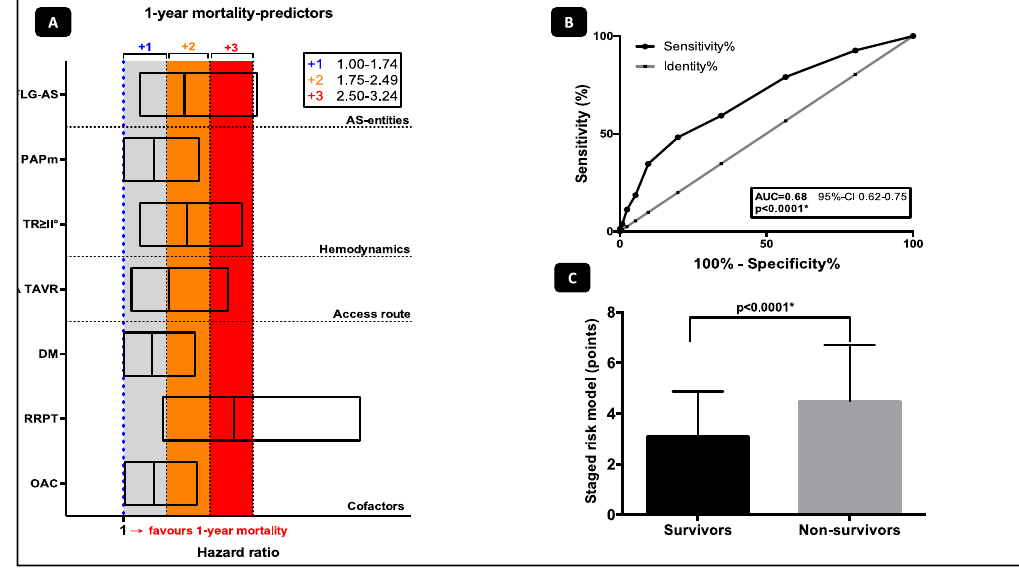
Figure 1. ( A ) Awarding of points based on the aforementioned HR calculation for predictors of 1-year mortality according to the categories (a) AS-entities (b) cardiopulmonary hemodynamics (c) comorbidities, and (d) different access route in a multivariate cox-regression adjustment model: Predictors with a HR of 1.00 to 1.74 received 1 point, those with a HR between 1.75 to 2.49 received 2 points and those above a HR of 2.50 were assigned 3 points. ( B ) Area under the curve (AUC) as a receiver operating characteristic (ROC) by c-statistic for discriminating performance of the staged risk model. ( C ) Cumulative calculation points comparing survivors and non-survivors. Table 1. Univariate and multivariate Cox regression analysis with mortality as the dependent variable.